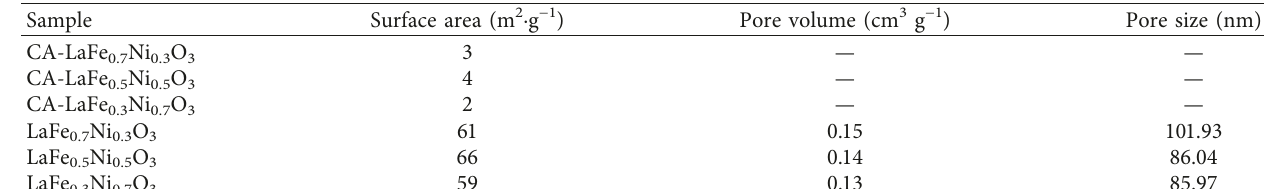
Table 1: Textural properties of the prepared catalysts.